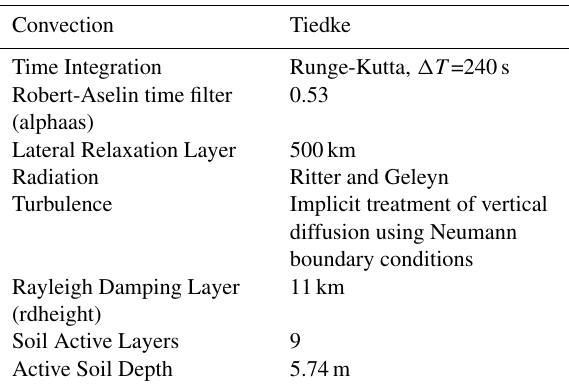
Figure 2. Orography map of the COSMO-CLM simulation domain in rotated coordinates. Table 1. COSMO-CLM Main model configuration